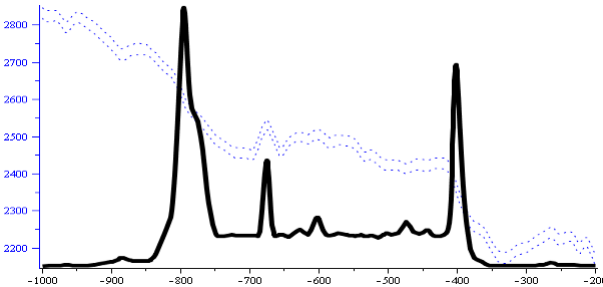
Fig. 2. Calibration graph of 2500 ± 100 14 CBP (via the IntCal04 calibration curve; Reimer et al., 2004), using the discrete method. The height of the black line indicates the probability for the cor- responding calendar year (scale not shown). The 1 σ extents of the calibration curve are indicated by the dotted blue lines; the vertical axis, shown in blue, pertains to the calibration